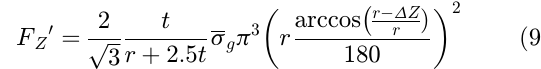
Fig. 7. Action results of a control